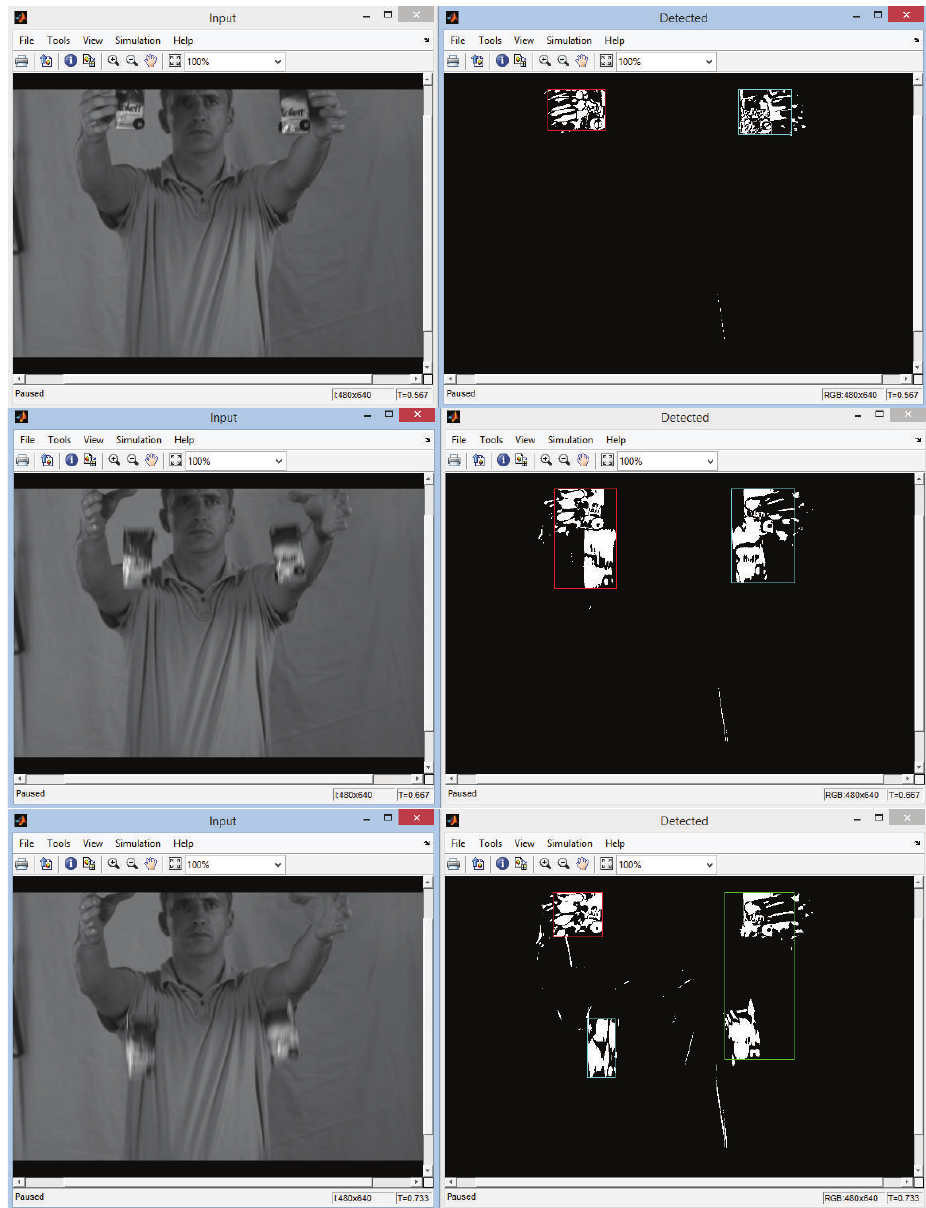
Figure 5: Analysis of extent of stimuli for the drop test